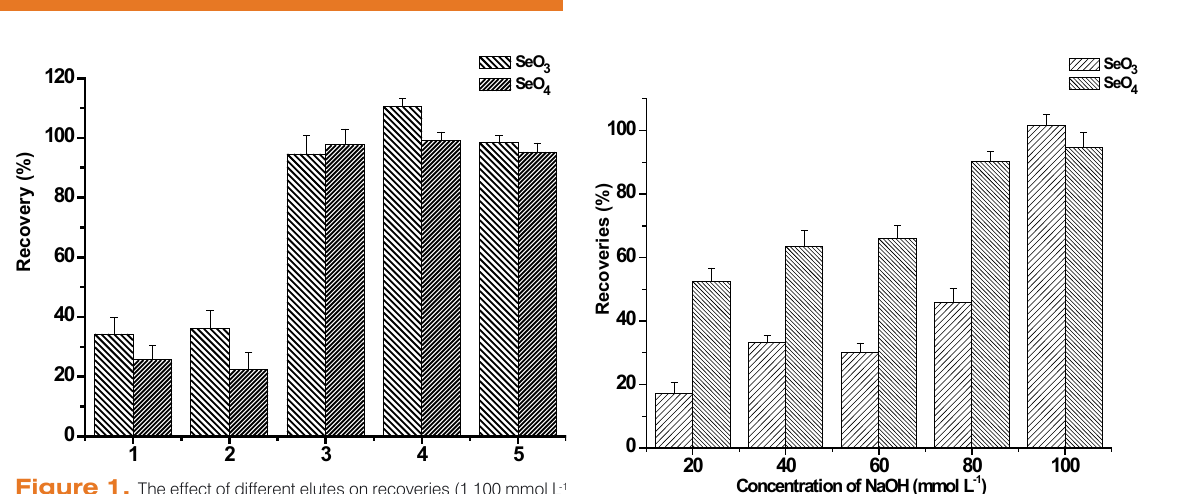
Figure 1. The effect of different elutes on recoveries (1 100 mmol L -1 , 3 100 mmol L -1 HF, 4 100 mmol L -1 HCl, 2 100 mmol L -1 HN0 3 NaOH, 5 100 mmol L -1 NH OH). Figure 2. The effect of NaOH concentration on recoveries. 4